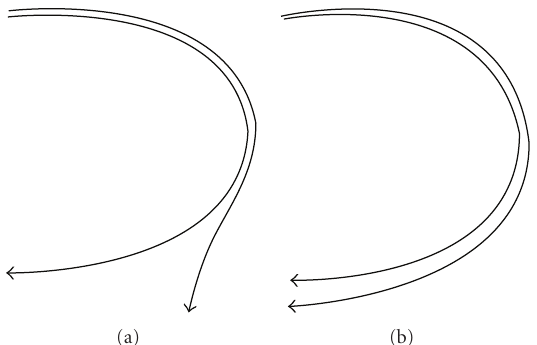
Figure 1: The evolutions of slightly di ff erent initial states (a) unstable trajectories; (b) stable trajectories [courtesy of Lorenz (1963)].